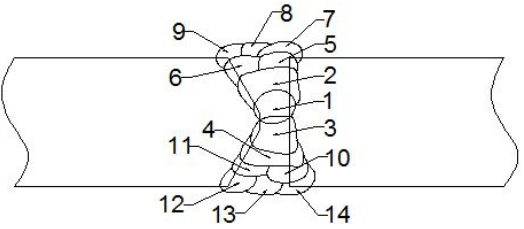
Figure 1. Welded plate (thickness 15 mm) cross ‐ section, welding passes: root 1–4, filler 5–14.